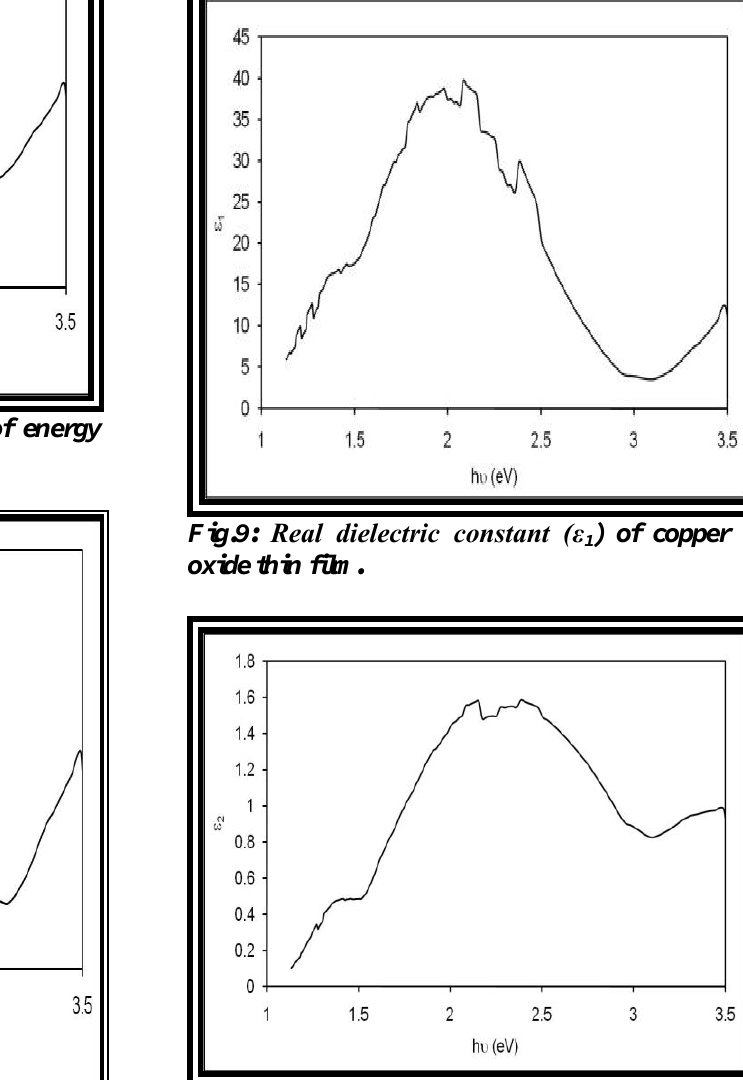
Fig.10: Imaginary dielectric constant (ε copper oxide thin